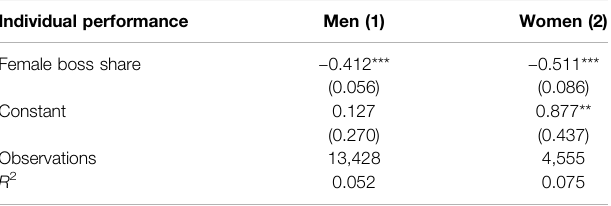
TABLE 4 | Regression results for linear downward- fl owing effects for men and women. Individual performance